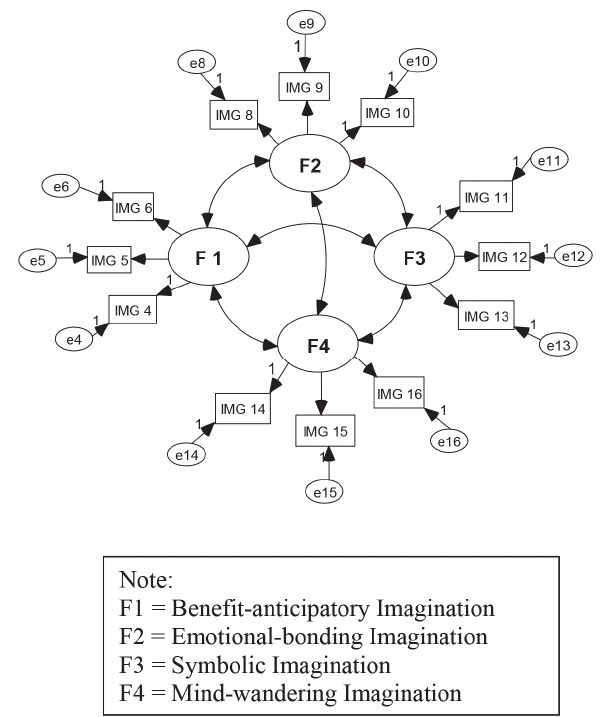
<Figure 2> Confirmatory Factor Analysis: A Baseline